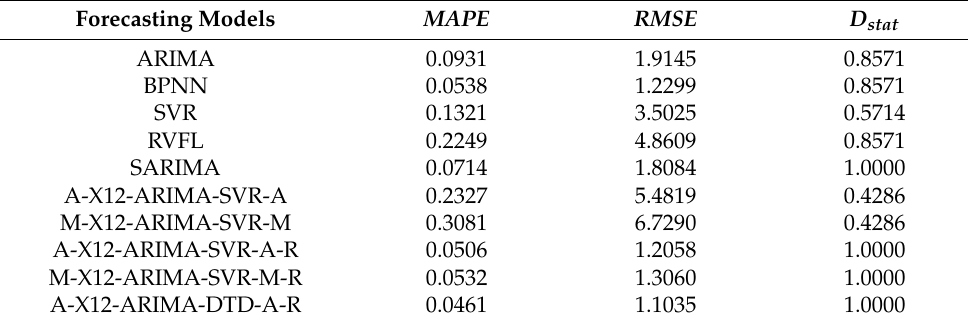
Table 11. Performance comparison of different models in Qinghai.